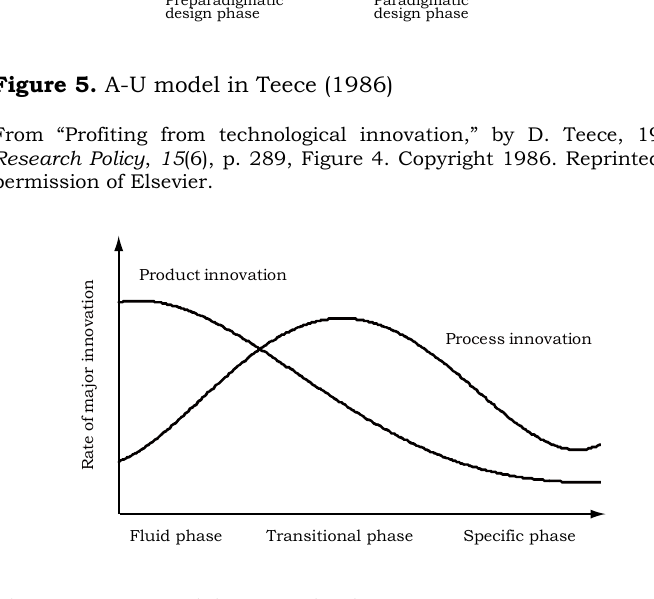
Figure 6. A-U model in Utterback